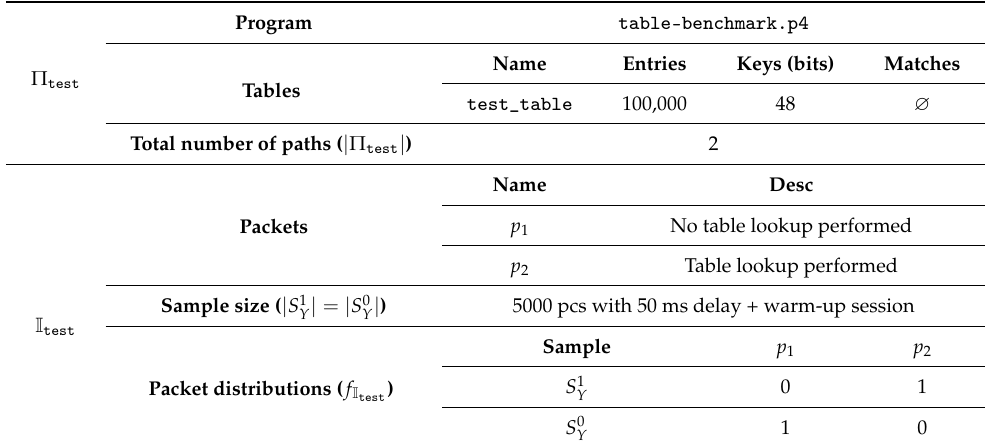
Table 6. ( Π test , I test ) configuration used for cost modeling ( (cid:98) θ Y ).